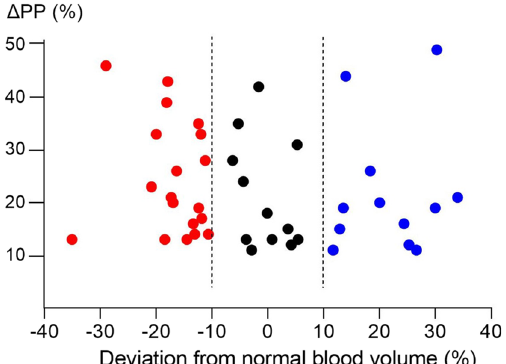
Fig. 3 Change in pulse pressure (ΔPP) following a passive leg raising test and deviation of blood volume from normal blood volume. Dotted lines illustrate limits of euvolemia